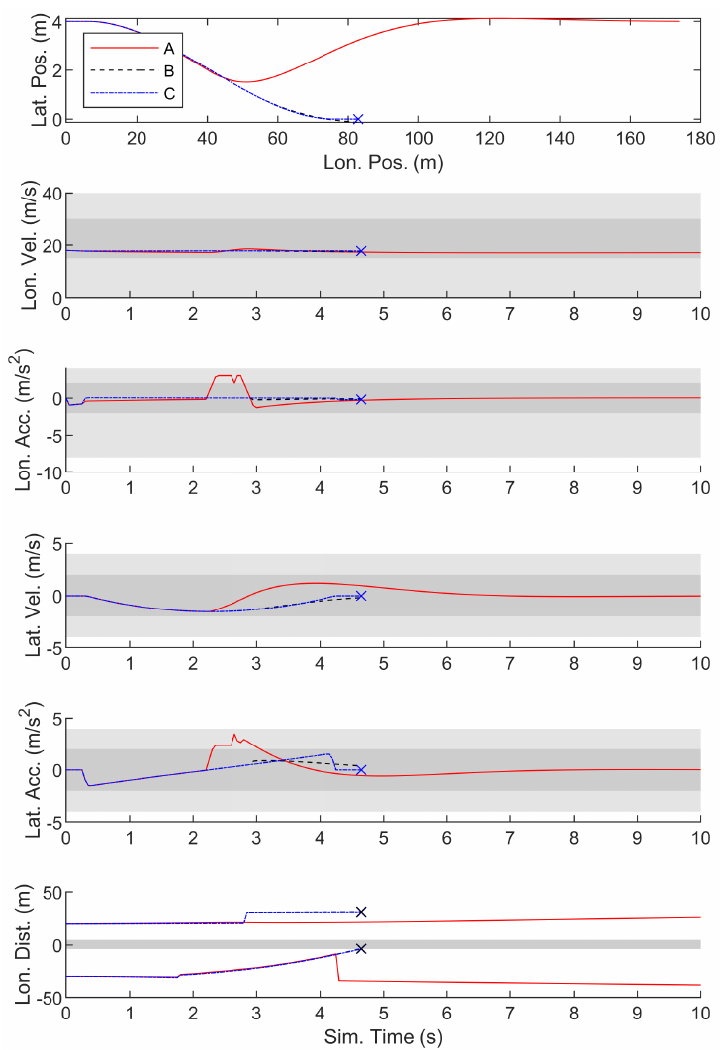
Figure 9. Simulation results for Scenario III. From top to bottom, the graphs of host vehicle V H are: 2-D trajectory, longitudinal velocity, longitudinal acceleration, lateral position, lateral velocity, lateral acceleration and host vehicle’s distance to the nearest front/rear